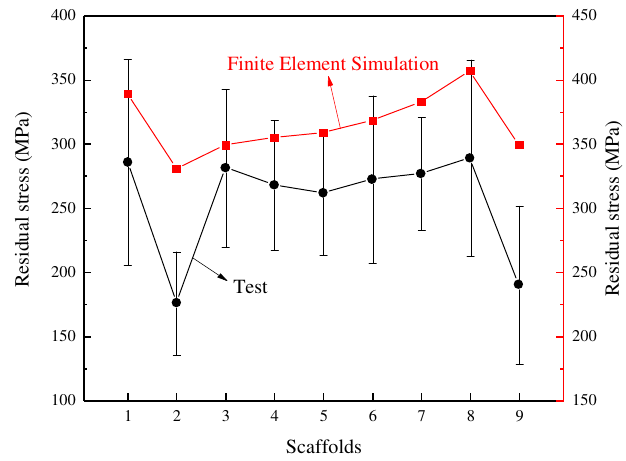
Figure 9. Finite Element Simulation and Experimental Test of Residual Stress.